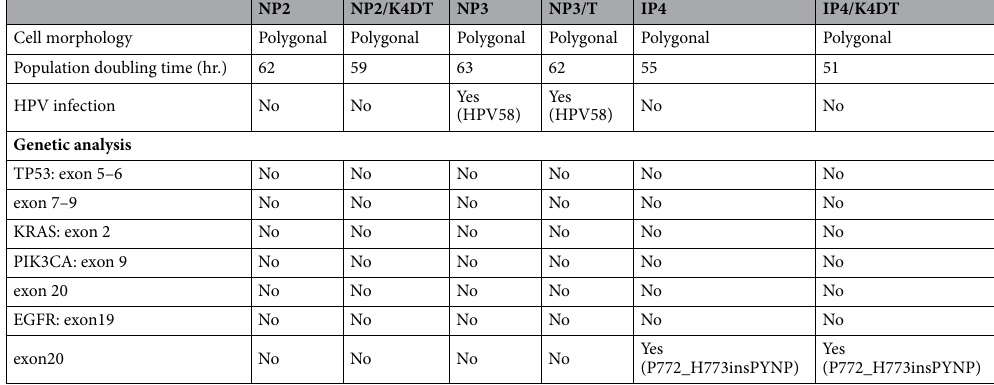
Table 2. Characteristics of the established sinonasal cells.